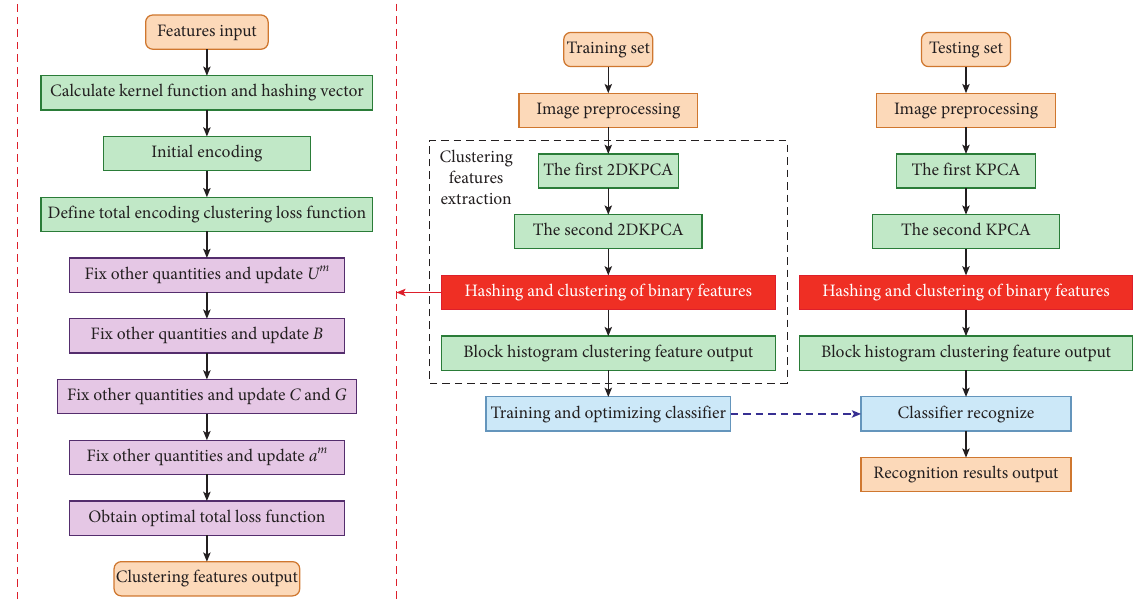
Figure 7: Flowchart of fruits boxes identification.